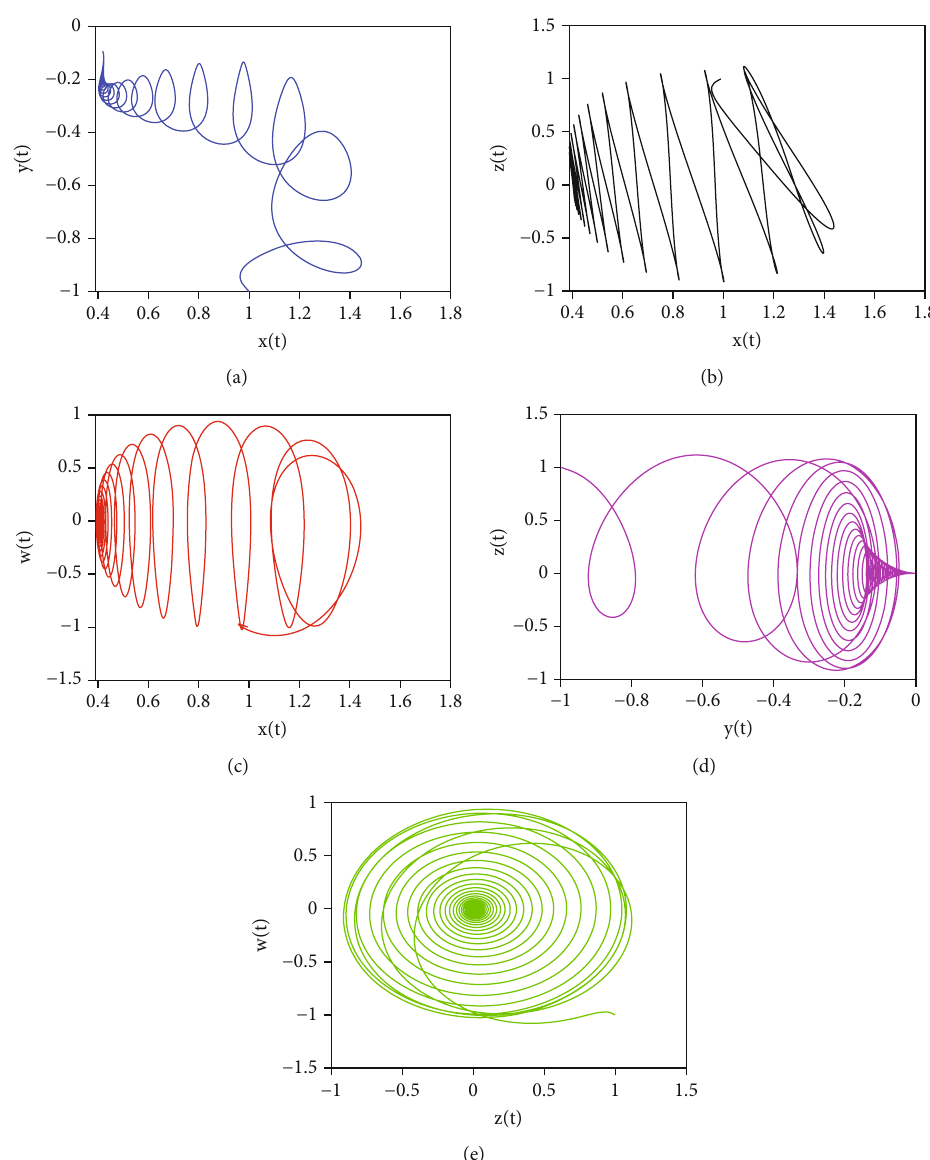
Figure 9: The behavior of di ff erent state variables of system 1 with fractional order ϖ = 0 : 98 and the parameters are considered as c = 2, d = 5